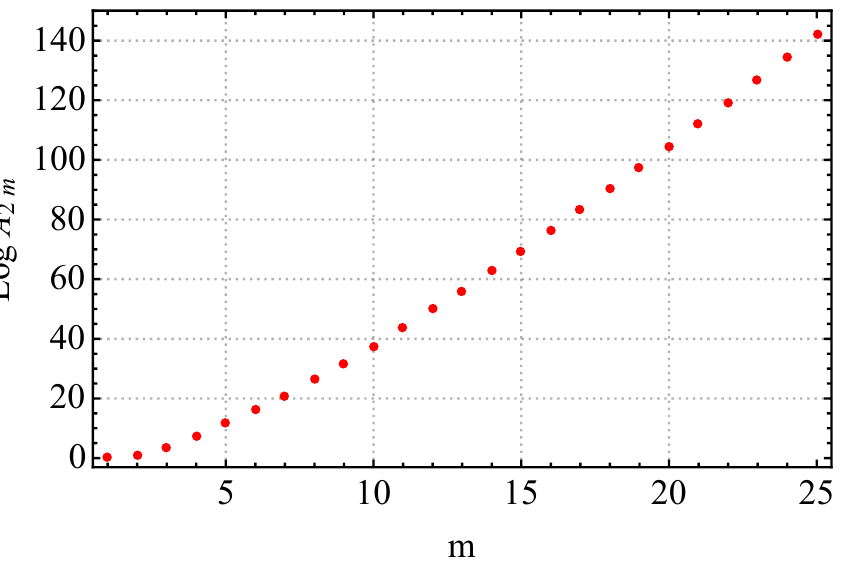
Figure 2 . Plot showing the value of A 2 m with different integer m